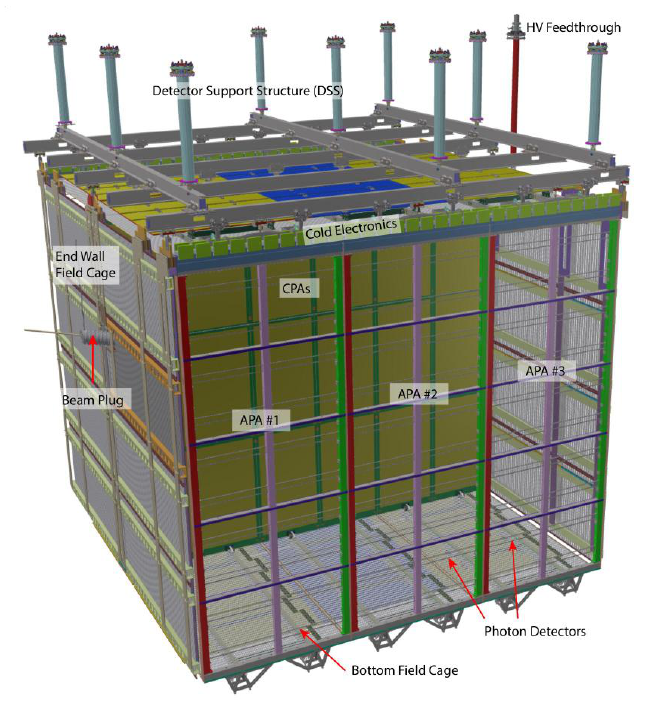
Figure 1. An overview of ProtoDUNE-SP